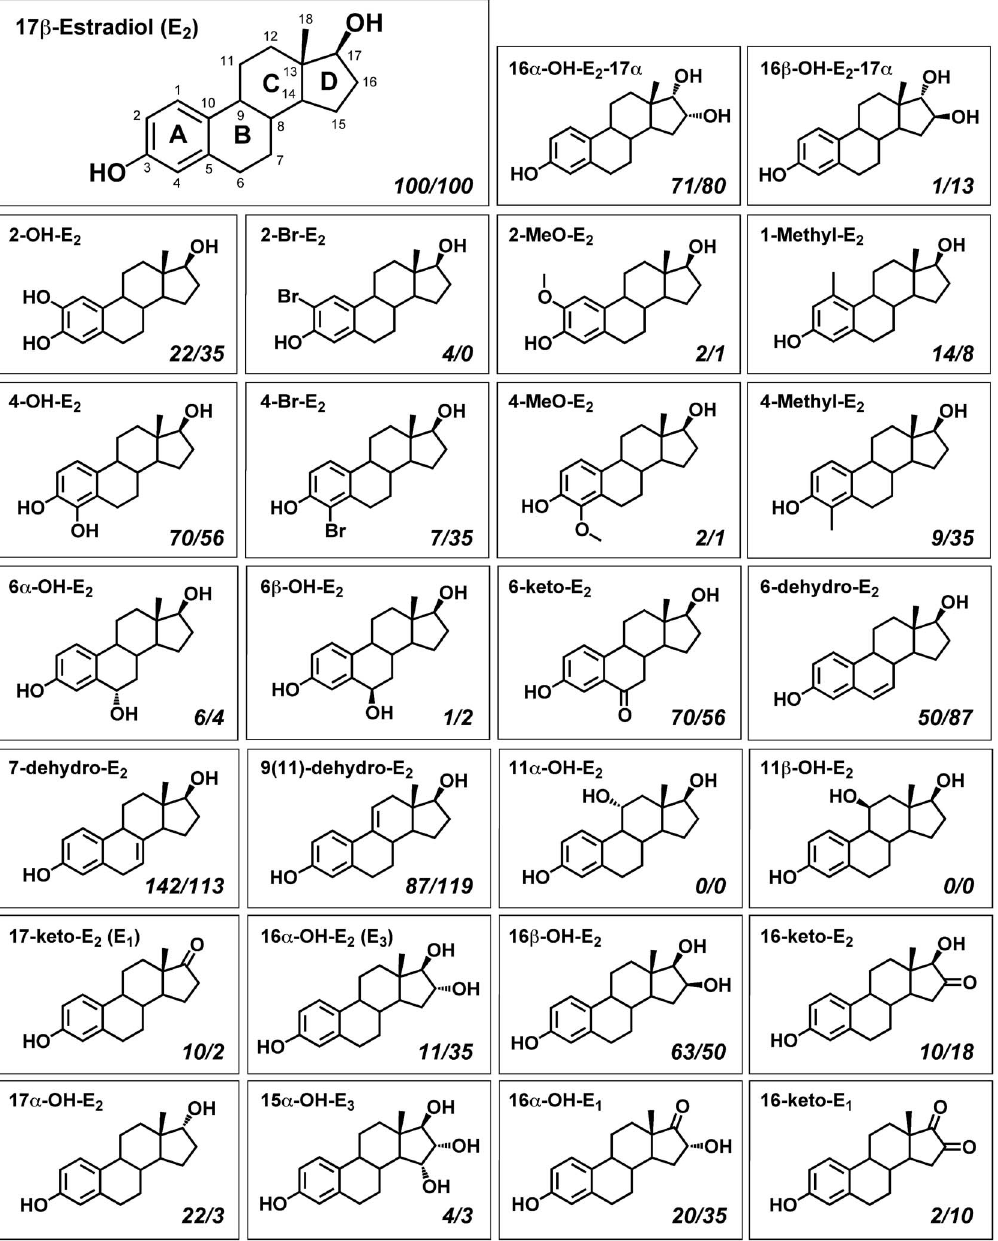
Figure 1. The chemical structures of 17 b -estradiol (E 2 ) and the 27 E 2 derivatives. The number of each carbon is labeled next to the atom in the E 2 structure. The names of the E 2 derivatives were shown in the upper left corner of each frame. The RBA values of the E 2 derivatives for ER a and ER b (data from Table 1 as % of RBA of E 2 ) were shown in the lower right corner of each frame. The numbers were rounded to the nearest integer due to space constraint.